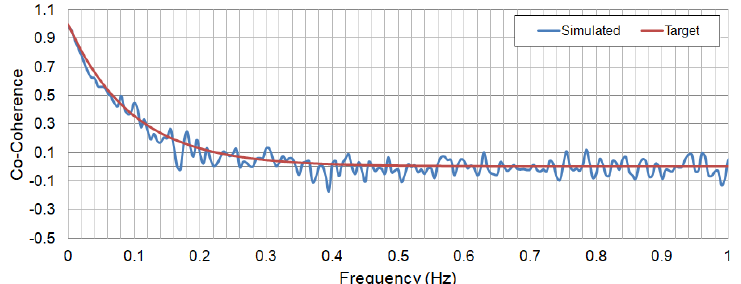
Figure 2. Typical spatial correlation between different points of the structure indicated by the coherence function.